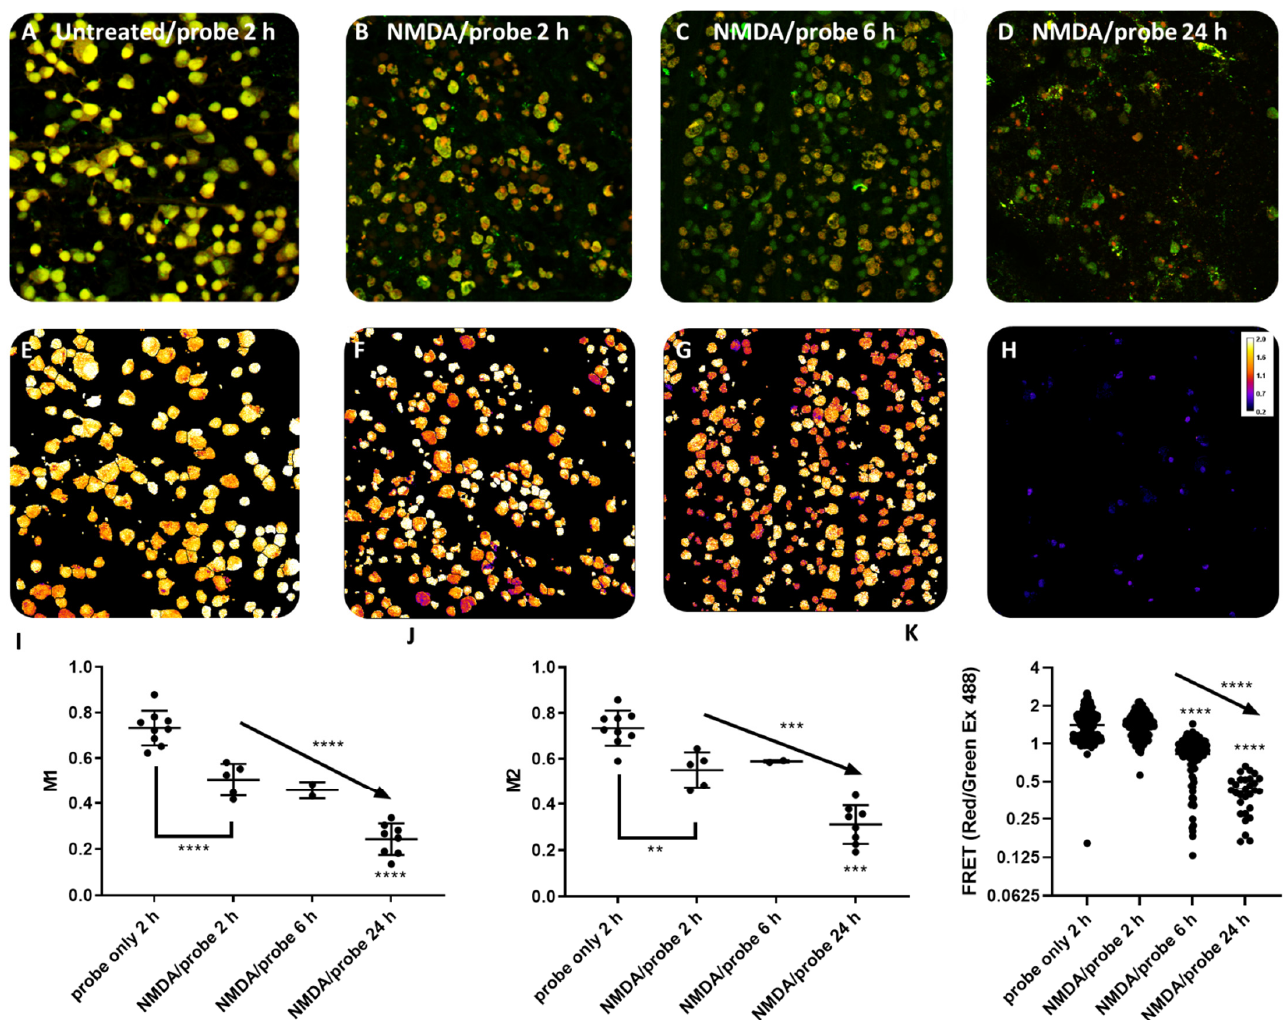
Figure 3. KcapTR488 detected apoptotic cell death in vivo quantitatively. Confocal images of KcapTR488 uptake in GCL cells from flat mount rat retinas showed a distinct labeling pattern under different treatment overlays of the AF488 signal (Green) and Texas Red (Red) ( A – D ) and distinct cell body FRET ( E – H ). Reporter-only control eyes were intravitreally injected with KcapTR488 for two hours ( A , E ). GCL cells (yellow) confirmed the reporter delivery and the colocalization of red and green in the healthy retina, and FRET/green ratios were high and comparable to the values found in vitro. Experimental eyes were treated with 50 nmol NMDA for 24 h and subsequently intravitreal injection of KcapTR488. Eyes were removed after 2 h ( B , F ), 6 h ( C , G ), and 24 h ( D , H ). The predominantly green cells in B and C indicated that caspase activation occurred in the cells with axonal transport and the removal of the cleaved NLS-Texas Red fragment out of the cell body, while AF488 stayed in the cell body. By 6 h, GCL cells had a more prominent red component in the cell body ( C ), which suggested a slowdown of NLS-Texas transport out of the cell body while retaining nuclear import. By 24 h ( D ), almost all cells had green cell bodies, and red-enriched nucleus labeling, indicating a near-complete loss of axonal transport while maintaining nuclear import. Data from whole fields were quantified for changes in two channel overlap with AF488 (green signal) and Texas Red (red signal) under ImageJ JACoP plugins ( I , J ). FRET was quantified on a per-cell-body basis; each datapoint represents an individual cell body ( K ). **** represents p < 0.0001, *** represents p = 0.001, ** represents p = 0.01. Arrows indicate the test for trend after the ANOVA analysis. In a healthy retina (no NMDA) from an animal sacrificed 2 h after KcapTR488 sensor injection (Figure 3A), there was robust uptake in GCL cells. The reporter was concentrated